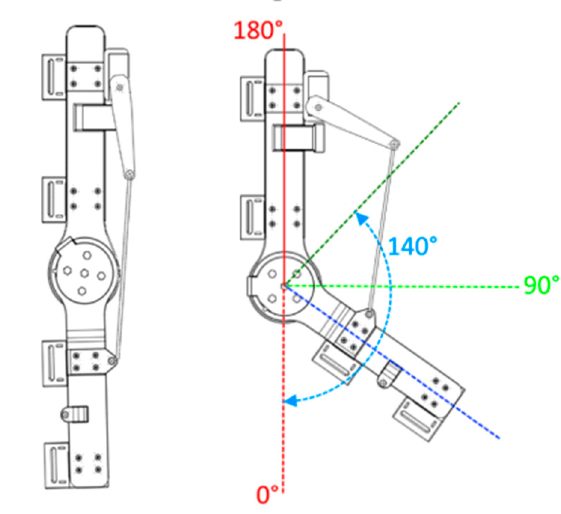
Figure 18. Motion analysis of the arm exoskeleton.